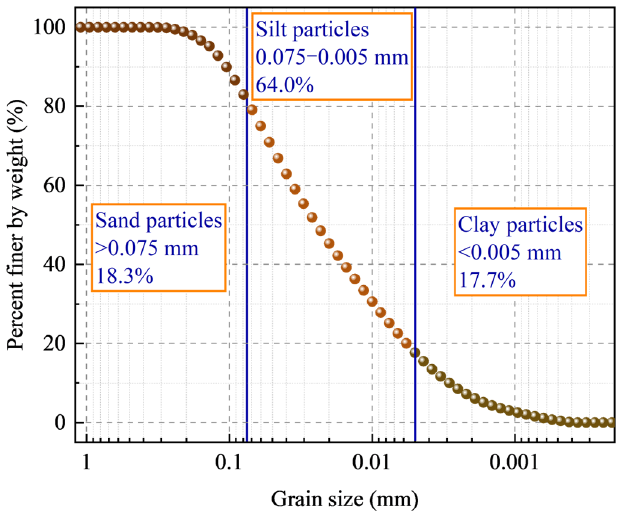
Figure 3. Average grain size distribution curve of the six sediment segments.